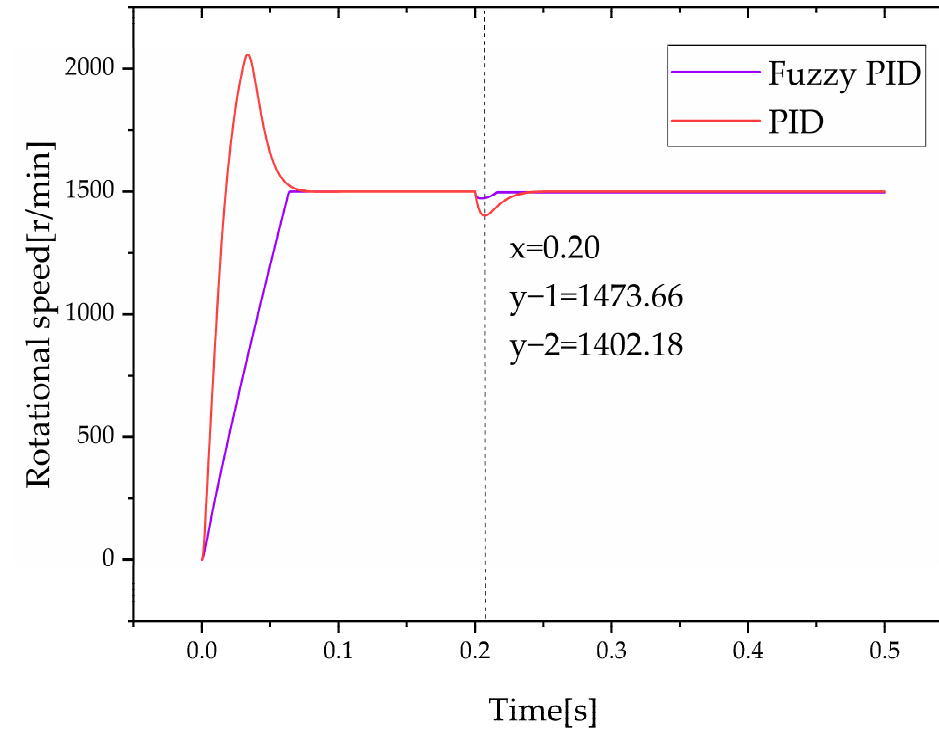
Figure 17. Fuzzy PID and PID controller revolutions.